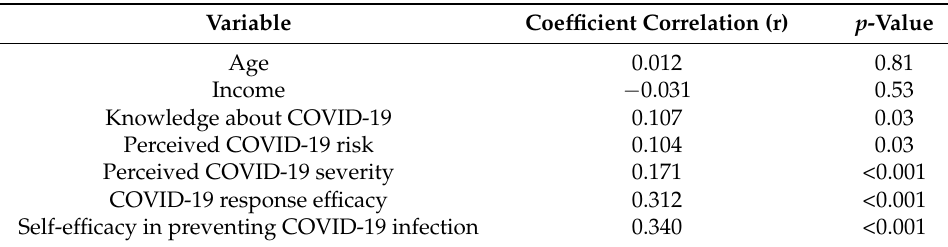
Table 2. Factor correlations with COVID-19 preventive behaviors.